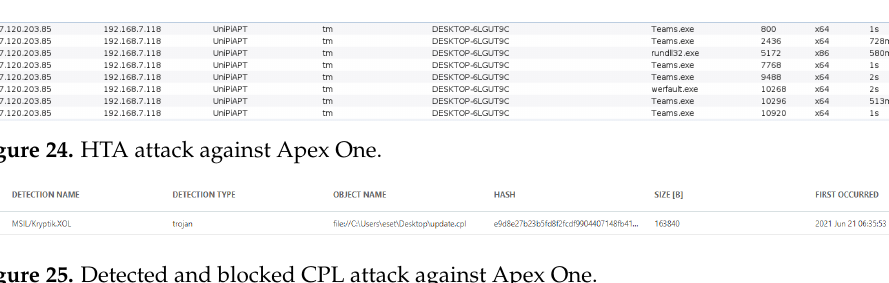
Figure 25. Detected and blocked CPL attack against Apex